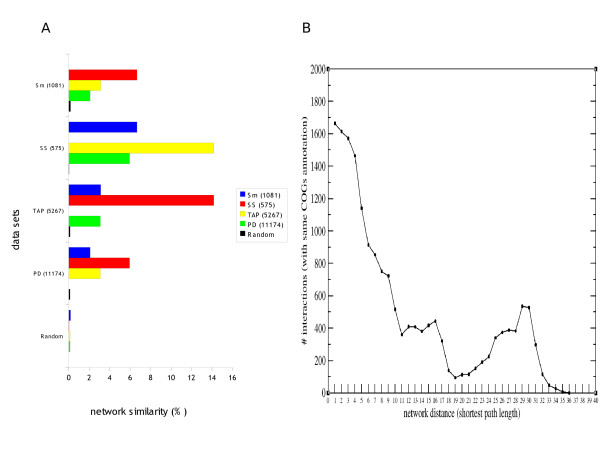
Network analyses. (A) Overlap of the S. meliloti network with three experimentally derived networks and randomly generated networks. Sm stands for S. meliloti network. SS and TAP refer to small- and large-scale experimental networks, respectively, present in DIP [31]. PD refers to a recently published pull down study [7]. Random refers to the average values of 100 random networks created with the same number of nodes and interactions as the Sm dataset. Error bars are negligible and not shown for clarity. (B) COGs [37] annotation from functional interactions and its correlation with network distance. 'X' axis stands for different network distances (shortest path lengths) in the S. meliloti network. Values at the 'Y' axis stand for the number of interactions having the same COGs categories in both interacting partners.